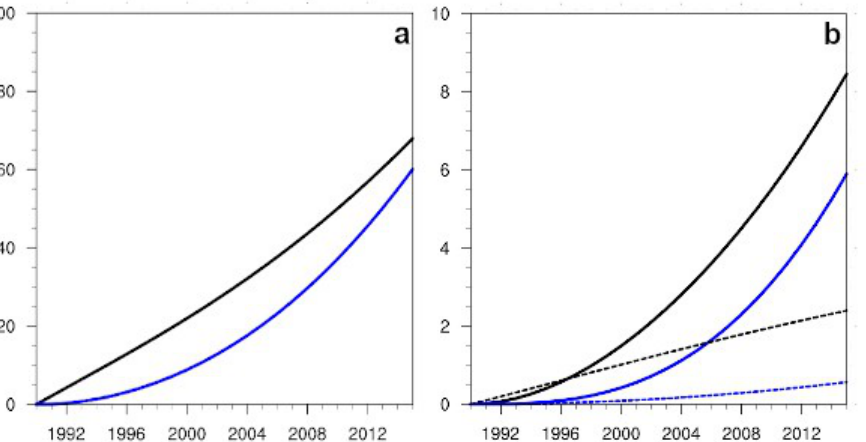
Figure 3. ( a ) Projections in time from the 1990 initial conditions of the Morris sensitivity indices, µ ∗ (represented with black lines) and σ (depicted with blue lines) for the variable passengers, in the case of National flights (S). In order to represent both indices in the same figure, the σ index has been rescaled by a factor 10. The sensitivities to the β parameter term are depicted with solid lines, and those to the a 22 term, with short dashed lines. ( b ) The evolution over time of the Morris sensitivity parameters for the variable Emissions. Colour codes and line styles are the same as in ( a